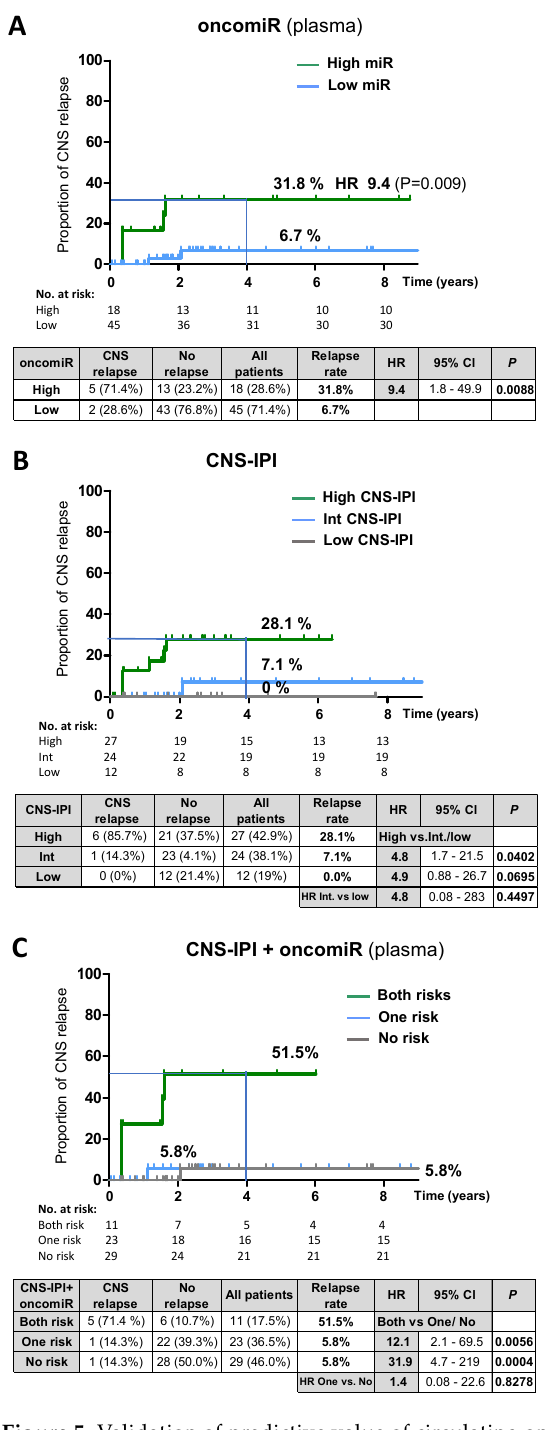
Figure 5. Validation of predictive value of circulating oncomiRs in plasma for CNS relapse in DLBCL. Kaplan-Meier estimates of risk for CNS relapse stratified by: ( A ) oncomiR levels in plasma acquired at the time of diagnosis, ( B ) CNS-IPI, and ( C ) combined prediction model of CNS-IPI and oncomiR risk. Both risks = high microRNA + high CNS-IPI; One risk = either high microRNA or highCNS-IPI; No risk = neither microRNA nor CNS-IPI are high. For details on risk stratification, see the supplementary methods. Note: HR, 95% Cl and P in the tables below the charts were obtained from univariate models of indicated categories. Abbreviations: CNS = central nervous system; IPI = International Prognostic Index; Int. = intermediate; HR = hazard ratio; n (%) = number of